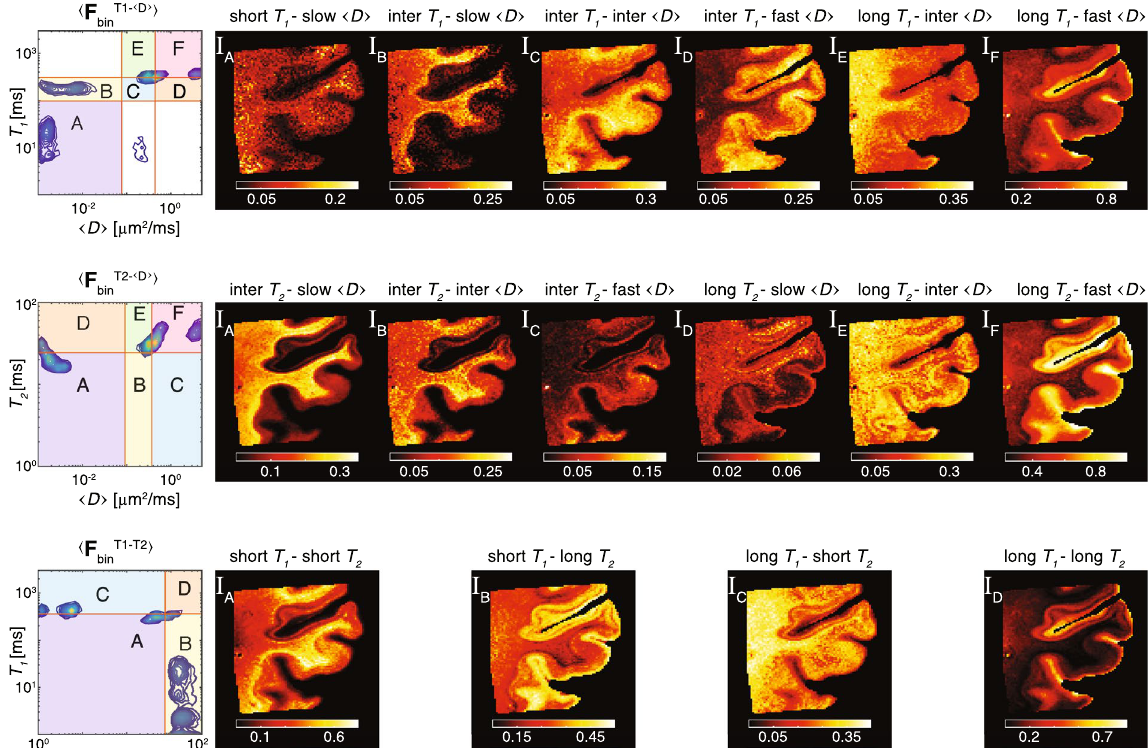
Figure 5. Proposed framework for processing and image reconstruction of multidimensional correlation MRI data. − F T D 1 , − F T D 2 , and − F T T 1 2 were computed using the proposed algorithm in Fig. 1 (top to bottom). bin bin bin These summarized spectra were then used to identify and define sROIs. Note that compared with the conventional approach, the sROI generator preserved more spectral components, has identified a significantly larger number of multidimensional peaks, and the spatial maps did not contain over-saturated